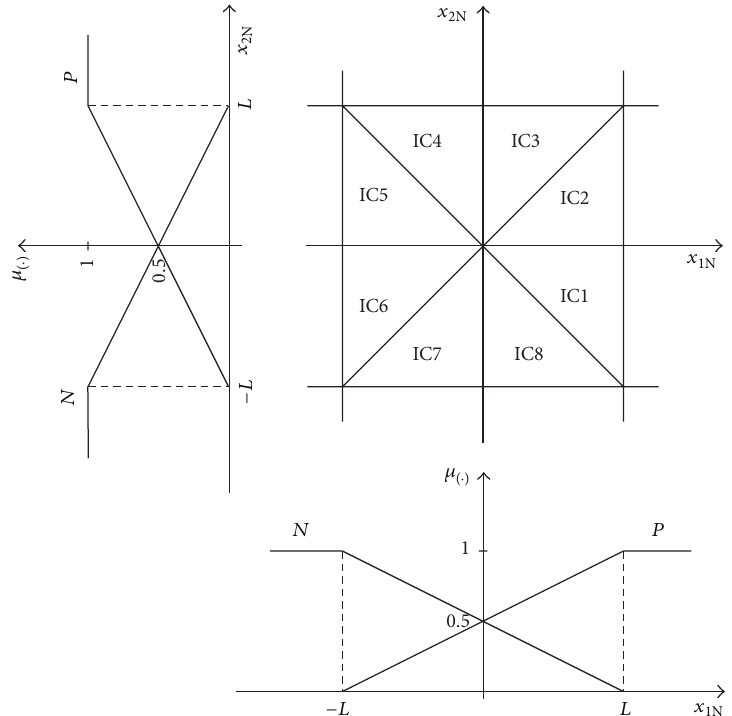
Figure 4: The regions of the fuzzy controller input values.